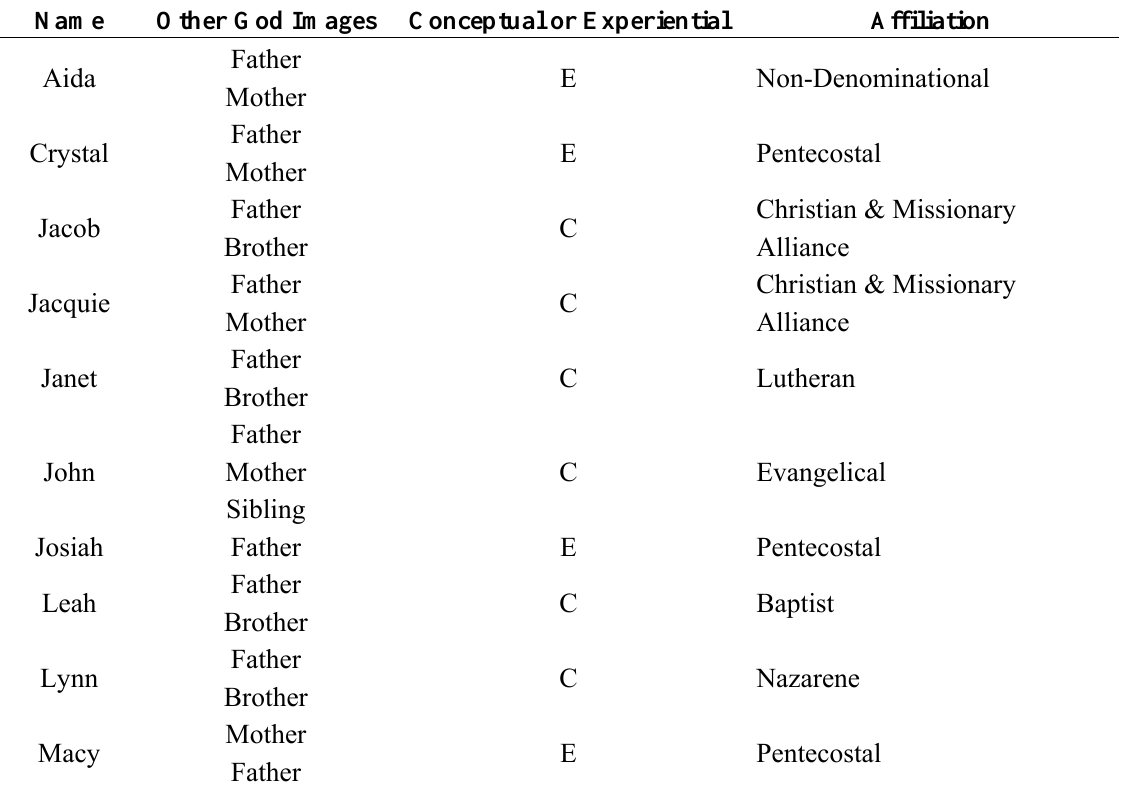
Table 2. Husband/lover images with related participant